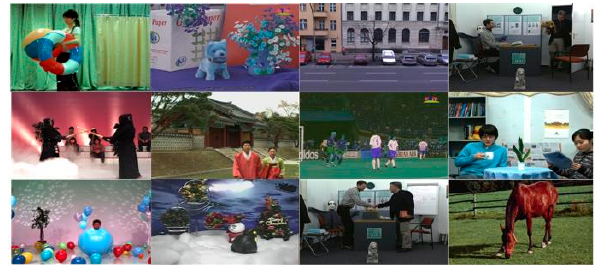
Figure 2. Left views of the training S3D images in this paper.